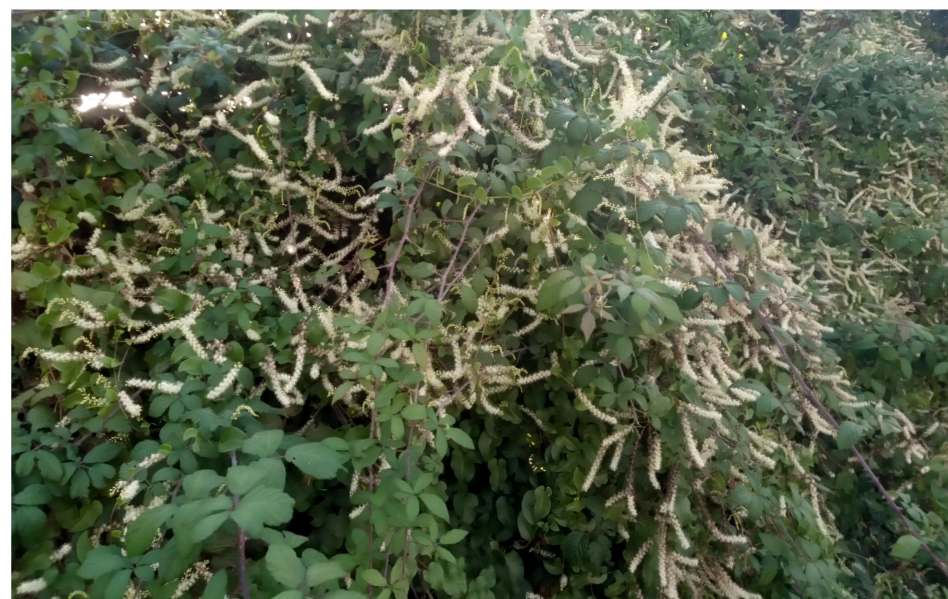
Figure 57. Anreedera cordifolia on Rubus ulmifolium dominated community (Acquedotti locality).